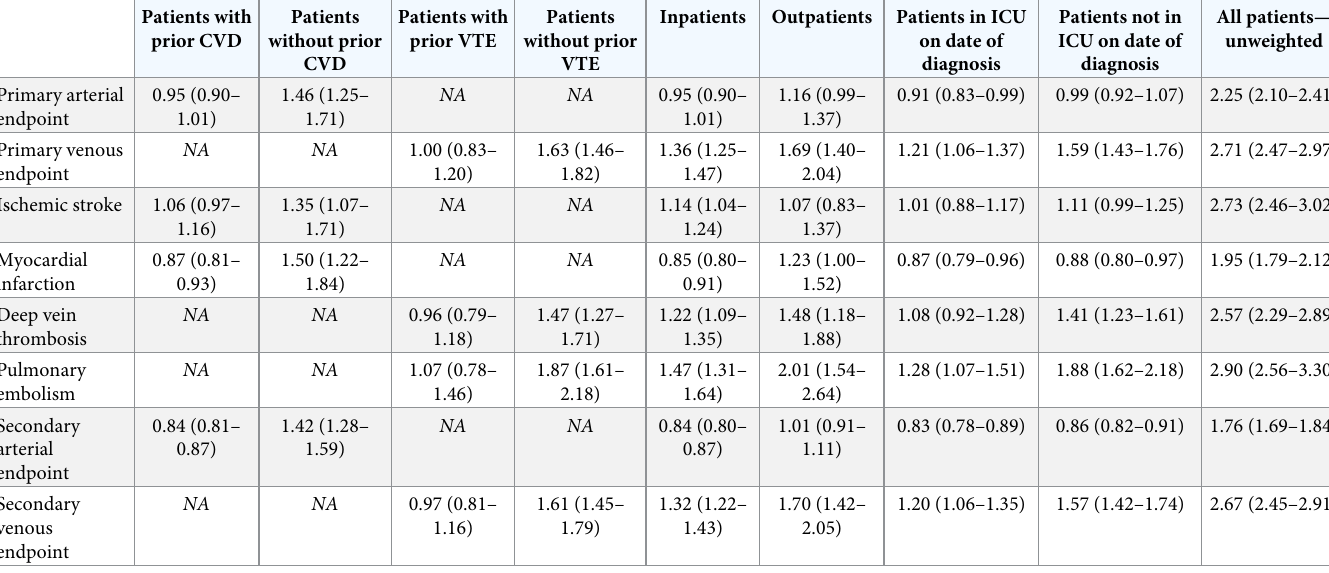
Table 3. COVID-19 vs. influenza hazard ratios for sensitivity